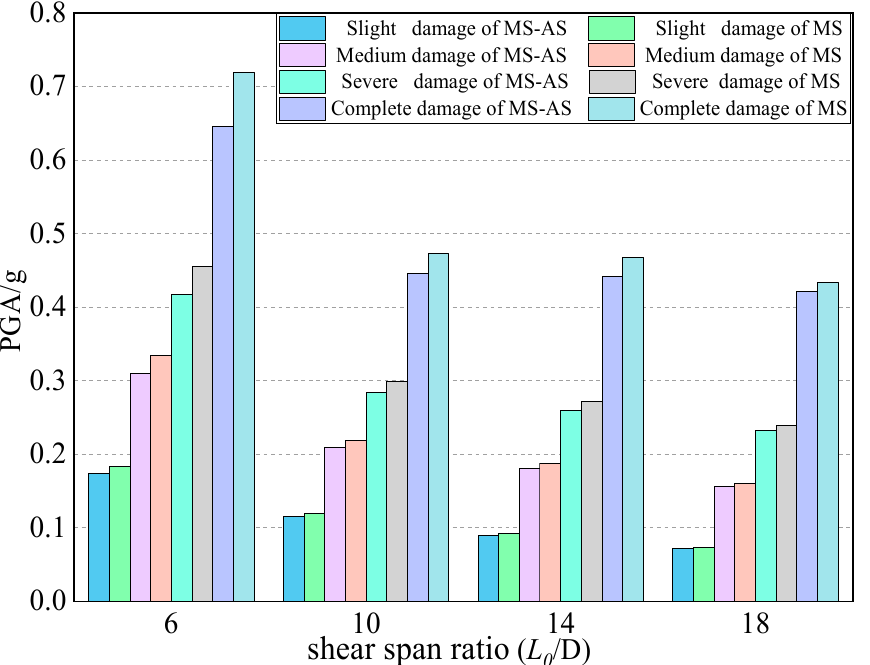
Figure 13. The median fragility PGA 50% under different shear-span ratio.